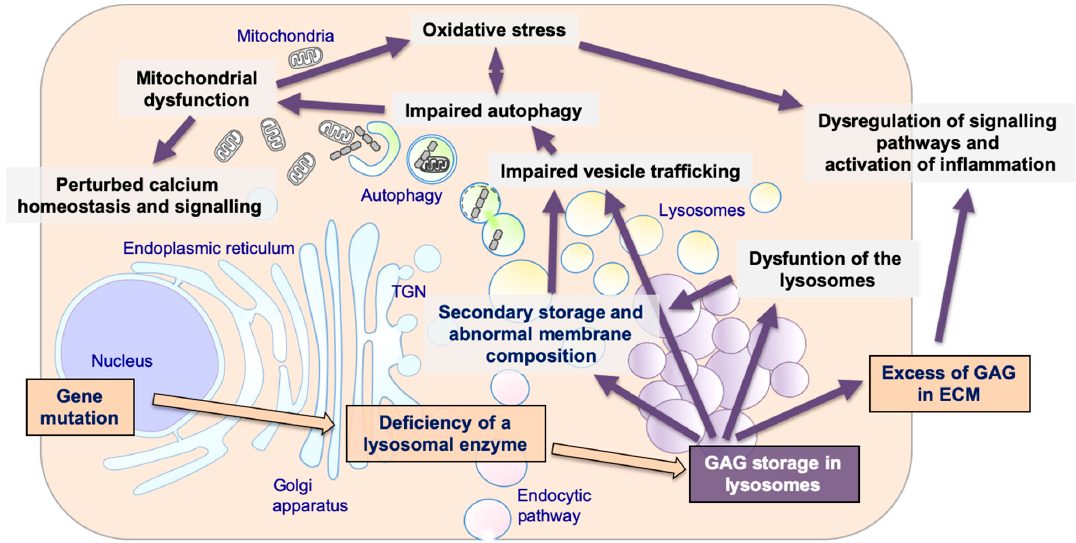
Figure 1. The pathogenetic cascade of mucopolysaccharidoses (MPSs). Multiple pathogenetic events in MPSs, including primary storage of glycosaminoglycans (GAGs) and secondary disrupted pathways: secondary storage of different substrates and abnormal membranes composition; impaired fusion and vesicles trafficking; impairment of autophagy; mitochondrial dysfunction and oxidative stress; dysregulation of signaling pathways and activation of inflammation; impaired calcium homeostasis and signaling.